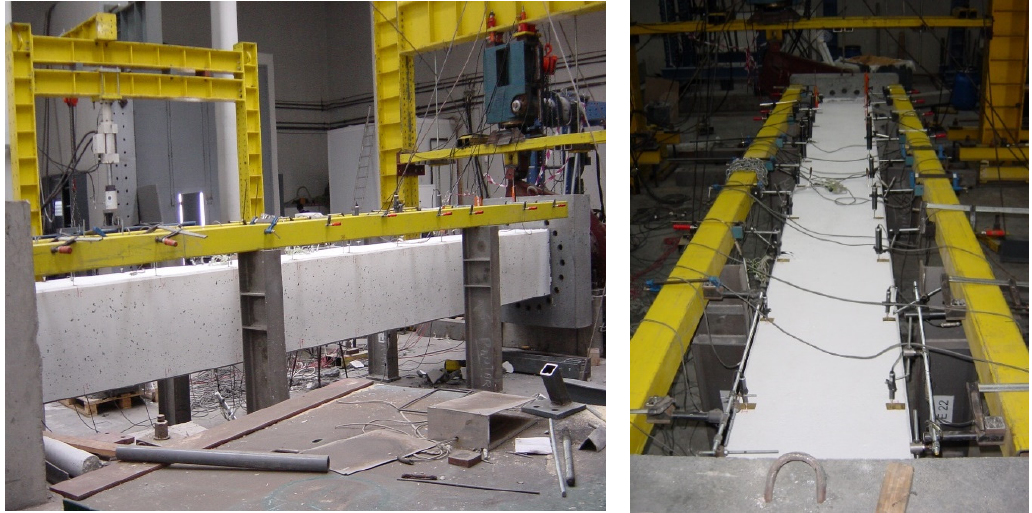
Figure 7. Beam specimen in test position.